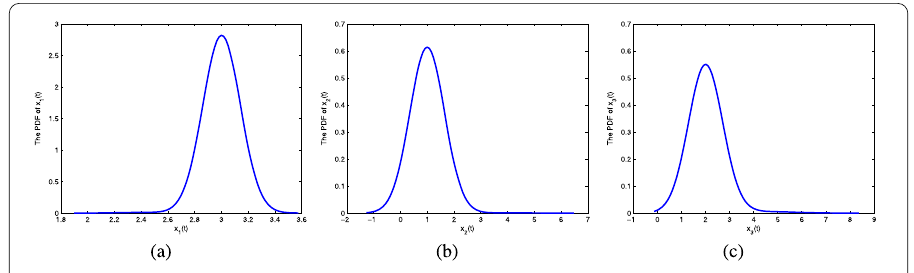
Figure 3 The probability density functions(PDFs) of three-species densities . (a) The probability density function (PDF) of x 1 ( t ) in Example 5.2; (b) The probability density function (PDF) of x 2 ( t ) in Example 5.2; (c) The probability density function (PDF) of x 3 ( t ) in Example 5.2.